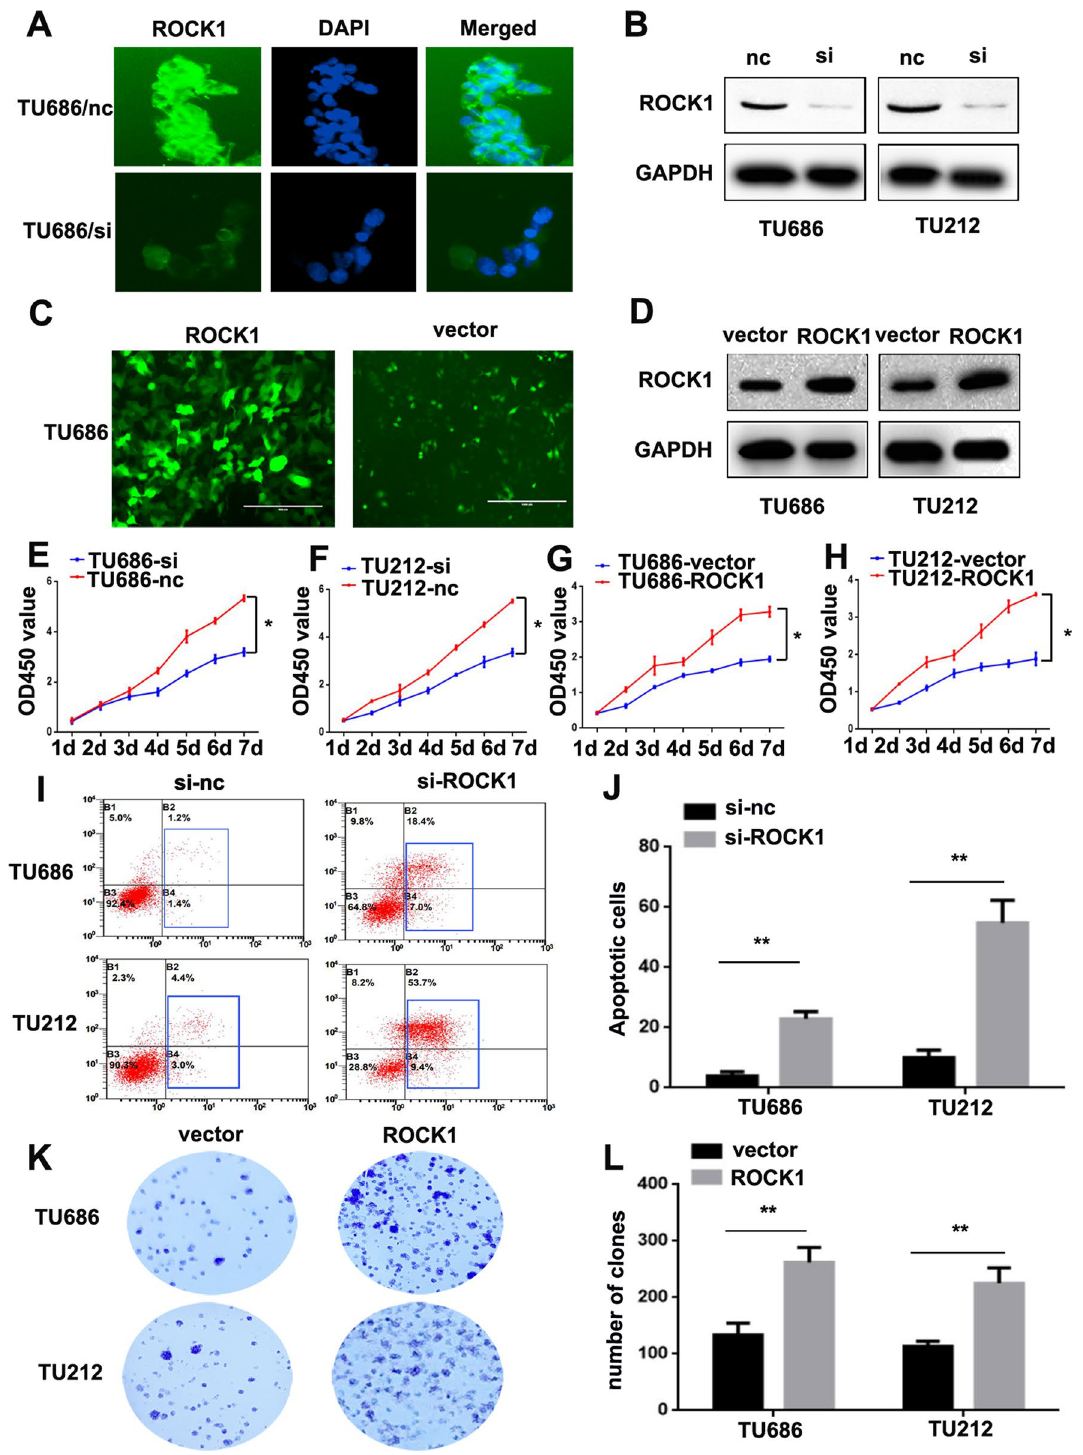
Fig. 2 ROCK1 promotes LSCC cells growth. A The ROCK1 level was reduced in TU686/si-ROCK1 cells. B The knockdown effect was verified by Western Blot. ROCK1 was significantly decreased in TU686/si-ROCK1 and TU212/si-ROCK1 cells. C Plasmid transfection was used to upreg- ulate the expression level of ROCK1 in TU686 and TU212 cells, the effect of transfection was verified via IF. D The expression level of ROCK1 was verified by Western Blot. ROCK1 was significantly increased in TU686/ROCK1 and TU212/ROCK1 cells. E , F. ROCK1 knockdown reduced cell proliferation (*P < 0.05). G , H Overexpression of ROCK1 increased cell proliferation (*P < 0.05). I , J ROCK1 knockdown induced cell apop- tosis (**P < 0.01). K , L Overexpression of ROCK1 promoted cell proliferation (**P <